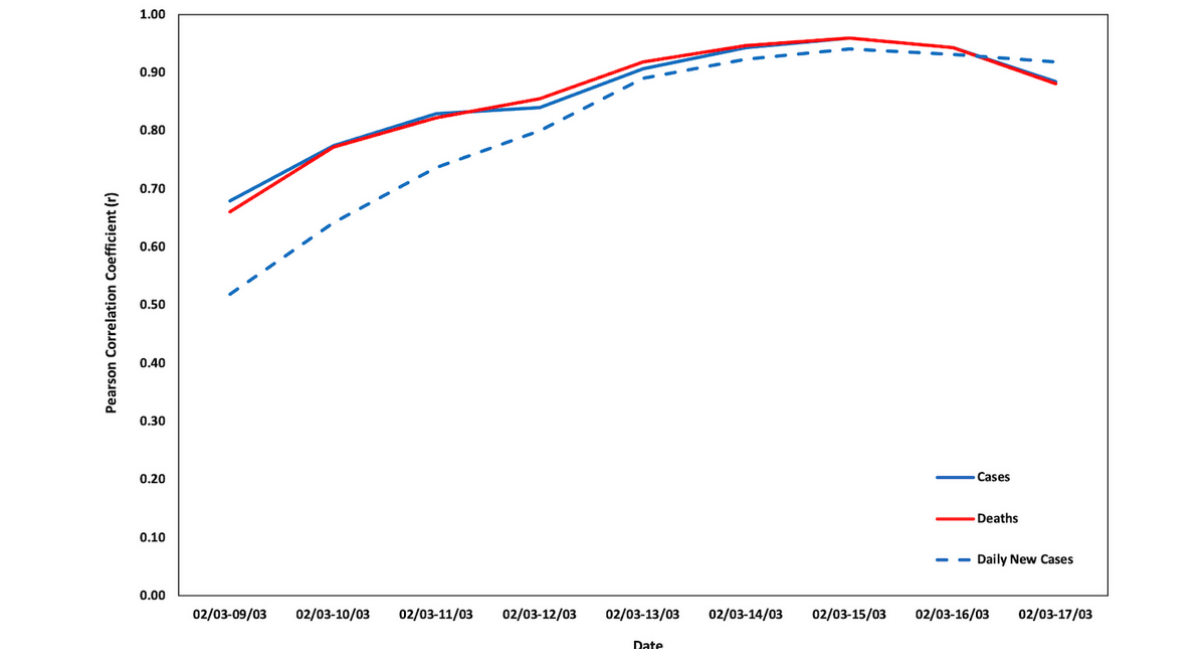
Figure 8. Changes in the Pearson correlation coefficients ( r ) for France.